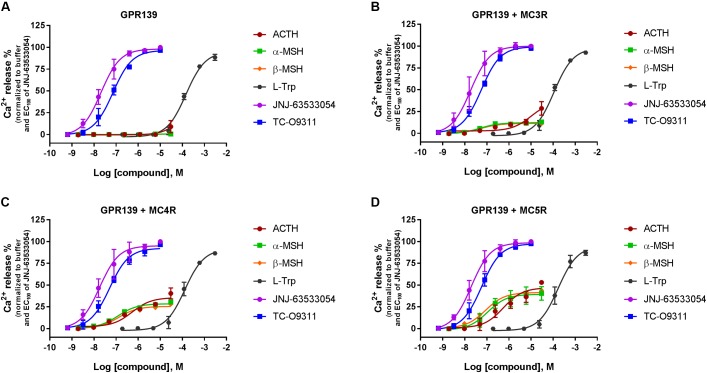
Concentration response of the melanocortin agonists ACTH, α-MSH, β-MSH, and GPR139 agonists (L-Trp, JNJ-63533054, and TC-O9311) calcium mobilization in a stable HEK-293 cell line expressing GPR139 (A) transiently co-expressing MC3R (B), MC4R (C), or MC5R (D). Data are the mean ± SEM of at least three separate experiments performed in duplicates.